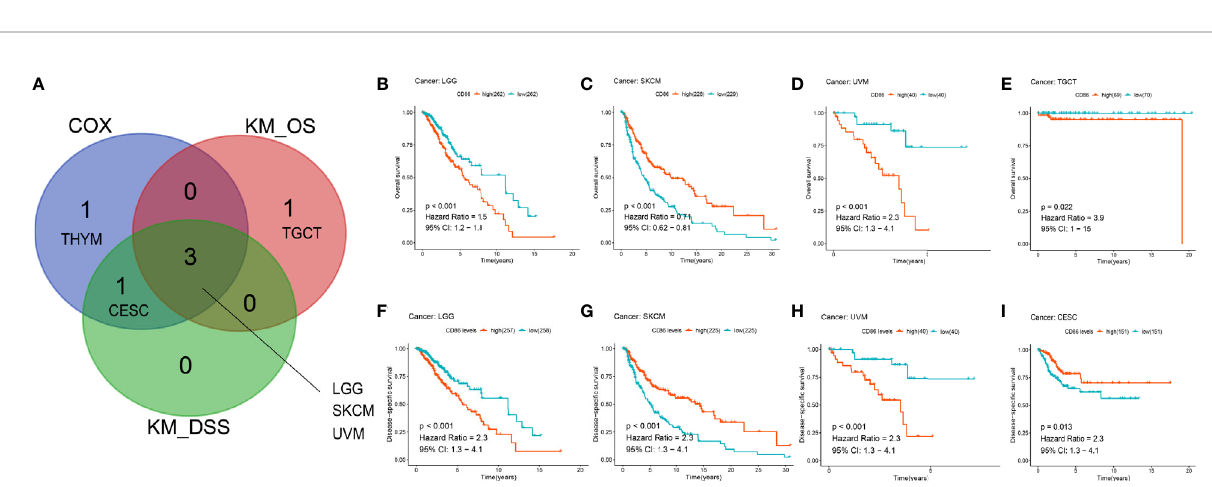
FIGURE 3 | Kaplan-Meier analysis with CD86 expressions in different cancer types. (A) The Venn diagram of the identi fi ed cancer types in cox regression analysis and Kaplan-Meier method. (B – E) Kaplan-Meier survival curve showing the prognostic value of CD86 on OS in LGG (B) , SKCM (C) , UVM (D) , TGCT (E) . (F – I) Kaplan-Meier survival curve showing the prognostic value of CD86 on DSS in LGG (F) , SKCM (G) , UVM (H) , CESC (I) .